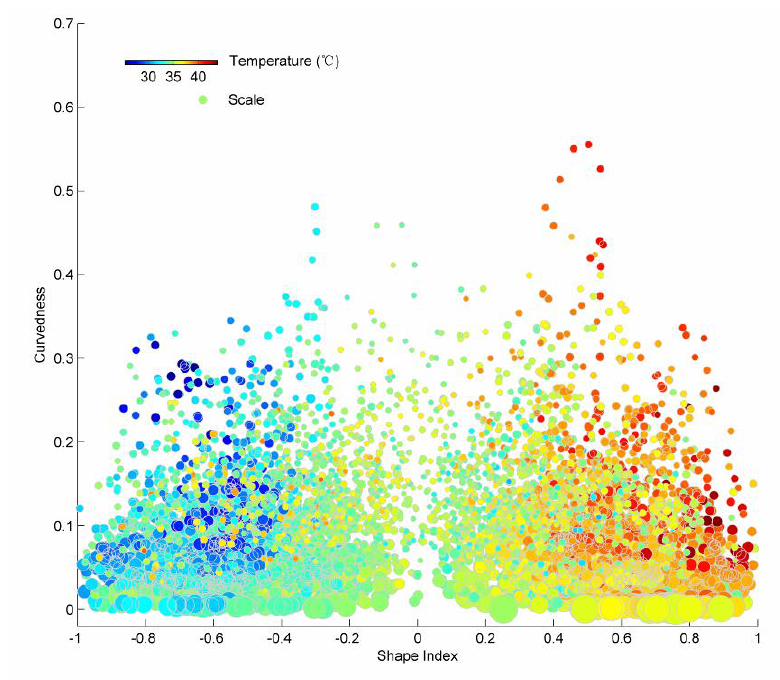
While the MSSI reveals the morphological characteristics in terms of shape and scale, the curvedness is obtained at the same time through Equation (4). It is necessary to examine how these parameters are related to on another. Figure (6) plots the MSSI, curvedness and scale together. The scale is indicated by the relative size of bubble as the second dimension of the graph. Temperature is also shown by the colour as the forth dimension. At least 4 properties appear to be evident. (1) Pixels with globally high temperature are more likely to be on local convex features. Few pixels with globally high temperature are of concave shapes, these pixels are assumed to be in urban areas,